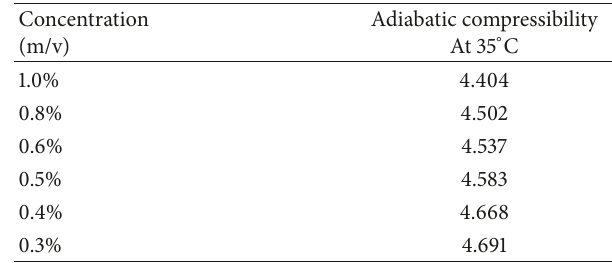
Table 4: Adiabatic compressibility ( × 10 −10 kg −1 ms 2 ) at different concentration at 1MHz for polyvinyl alcohol (PVA).